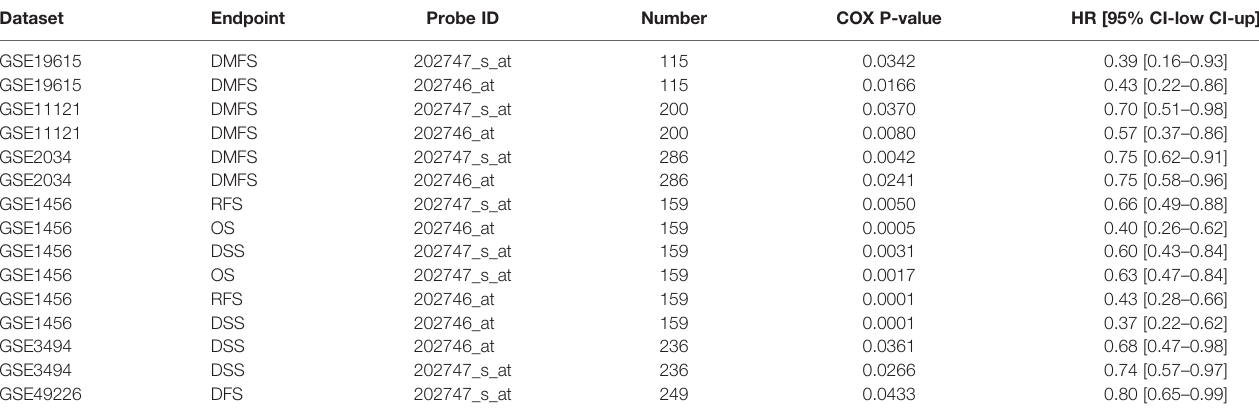
TABLE 1 | Survival analysis of ITM2A mRNA in breast cancer patients (the PrognoScan database).